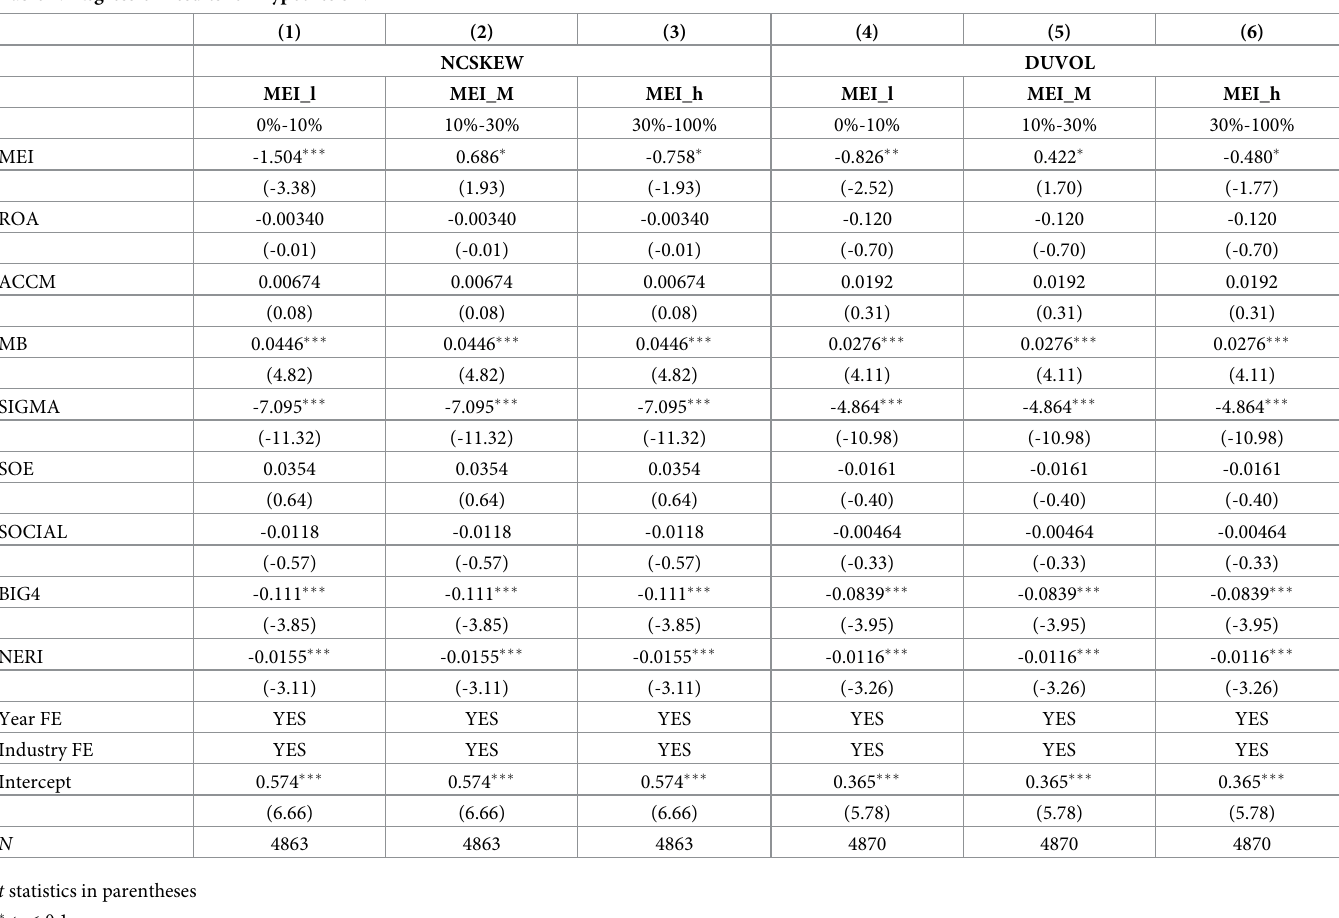
Table 2. Regression results for Hypothesis